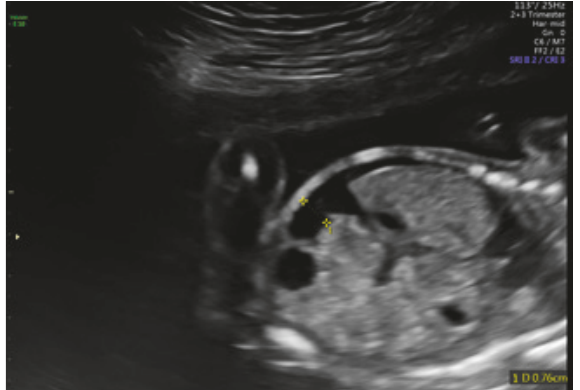
Figure 4: Anatomyultrasound at 20 weeks’ and 1-day gestation with fetal